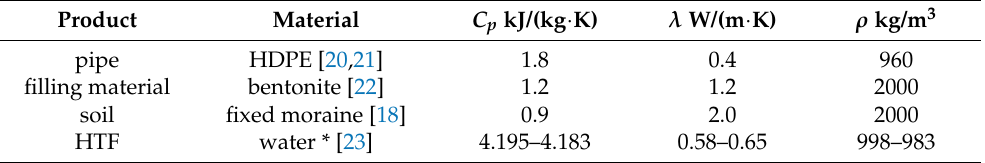
Table 3. Material properties of equipment used for the experimental set-up. Product